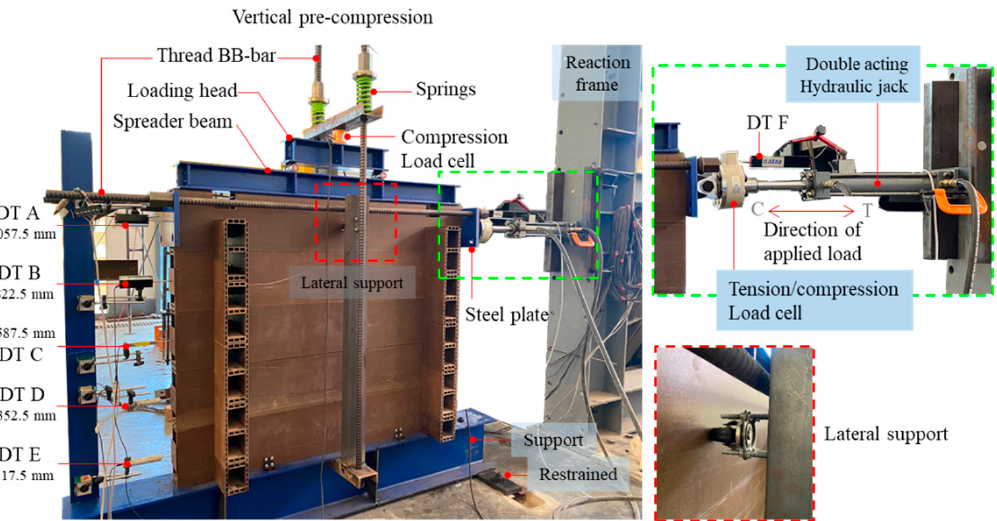
Figure 4. In-plane lateral load experimental setup (instrument positions and lateral support) performed on WPVC composite log-wall (C is compressive direction and T is tensile direction).